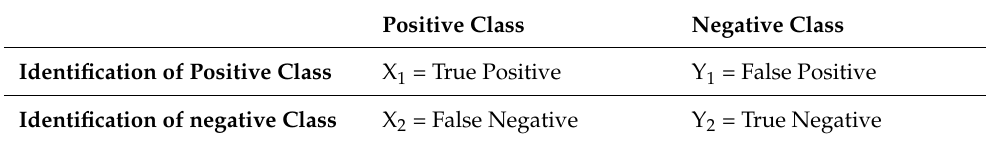
Table 3. The accuracy parameters.